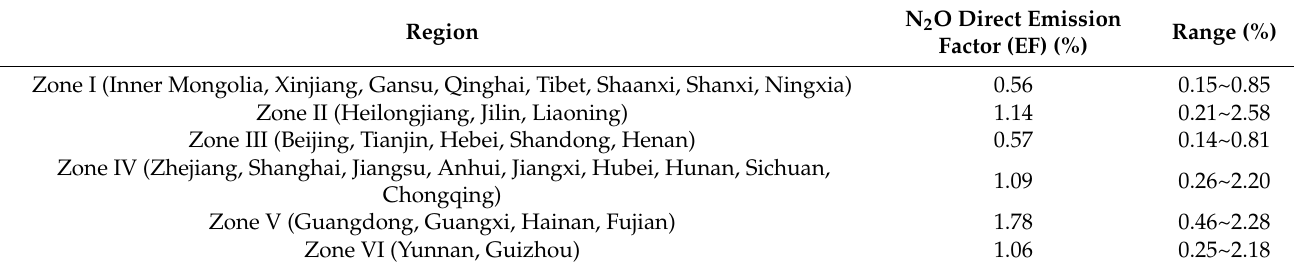
Table 1. Direct emission factors of agriculture induced N 2 O.